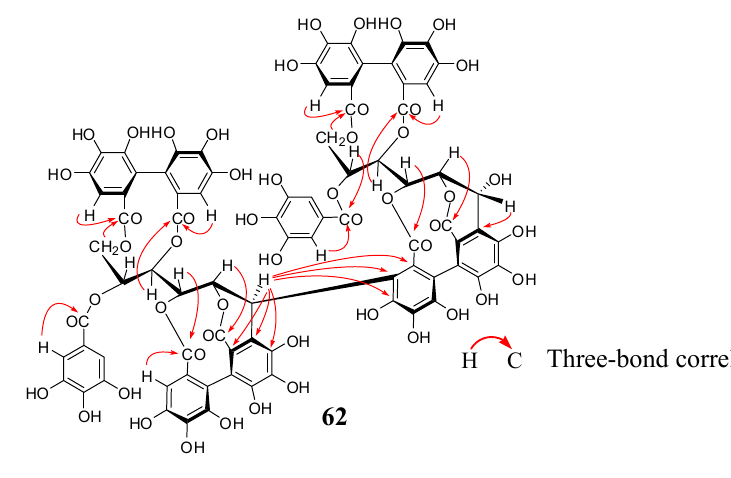
Figure 13. HMBC data for melasquanin A ( 62